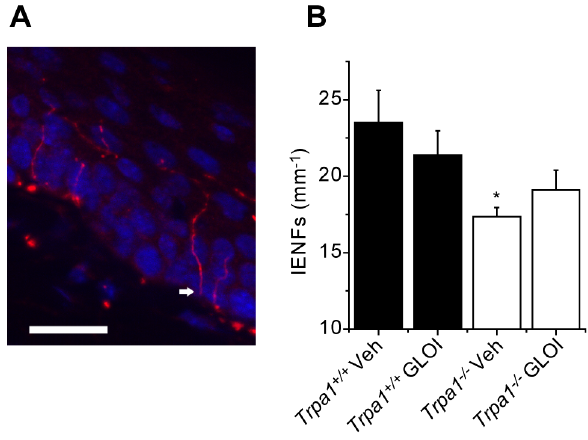
Figure 6. Intra-epidermal nerve fiber density is unaffected by 2 weeks GLO-1 inhibition. (A) PGP9.5 positive nerve fibers crossing the basal membrane into the epidermis (the white arrow highlights an example) in 8 m m sections of plantar skin (scale bar=20 m m). (B) Following two weeks treatment with the GLO-1 inhibitor (GLO-I, 50 mg/ kg every other day), the number of intra-epidermal nerve fibers crossing into the epidermis/mm skin was unchanged in both Trpa1 + / + mice and in Trpa1 2 / 2 littermates. Data were analyzed by ANOVA followed by Tukey’s HSD test (n=6 mice, *P , 0.05 compared to vehicle treated Trpa1 + / +